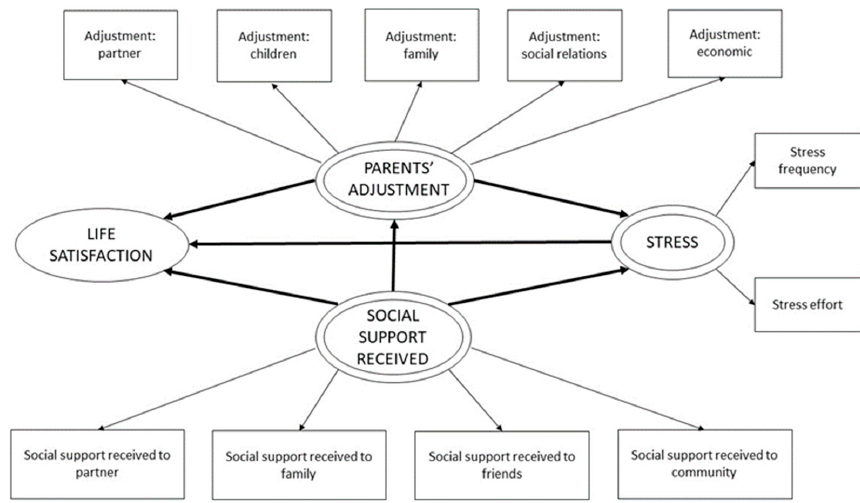
Figure 1. Conceptual model of social support received.